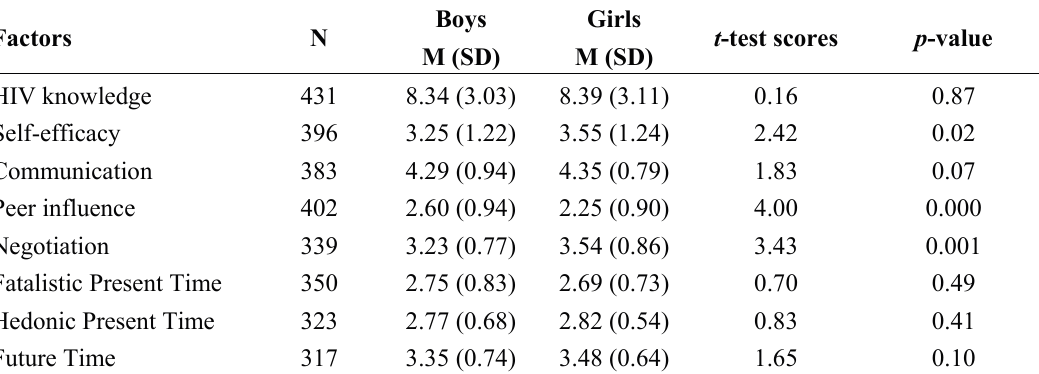
Table 4. Factors associated with sexual behaviors of boys and